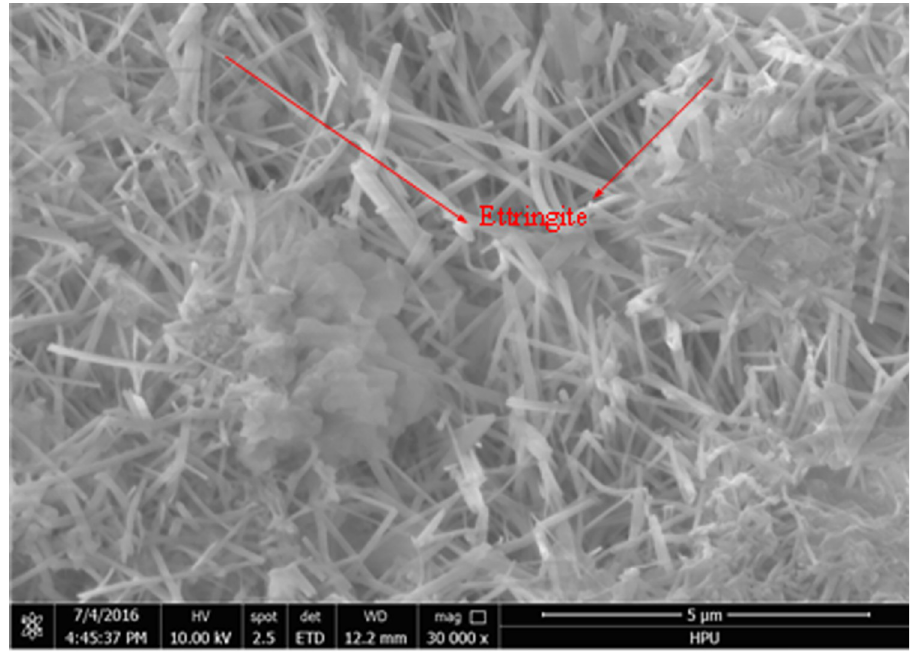
Fig 10. 3d ( × 30000).